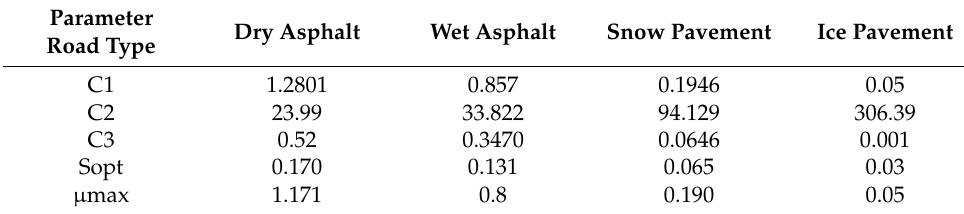
Table 1. Parameter values of four typical roads.